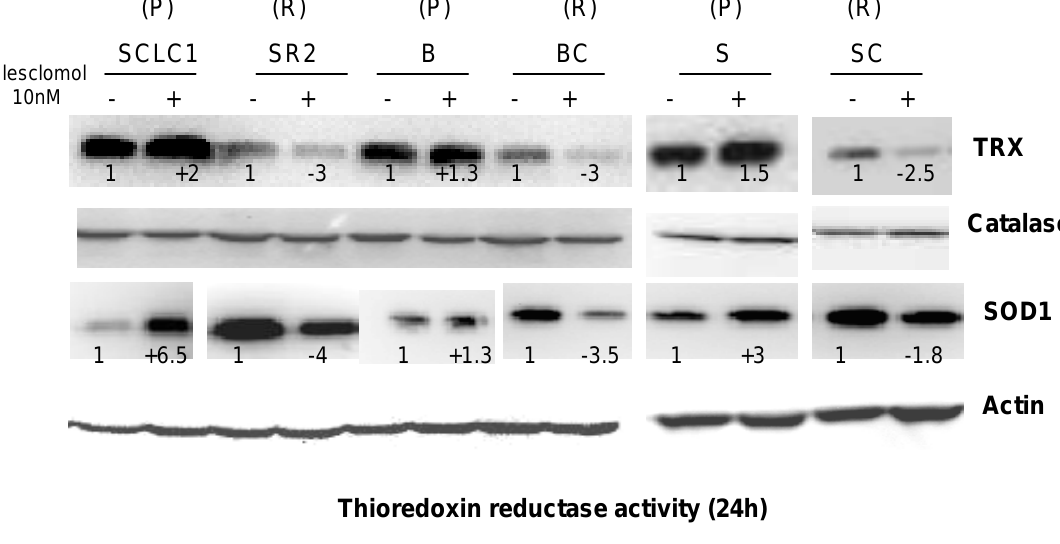
Figure 9. Immunoblot of lung cancer cell lines before and after treated with 10 nM of elesclomol for 24 h. TRX and TrxR activity are decreased in resistant lines and further decreased when treated with elesclomol. There is no significant change in catalase level. On the other hand, SOD1 levels are increased in all of the resistant cell lines (R) and is decreased upon treated with elesclomol. The number below each lane depicted the changes from its control which was arbitrarily set at 1. All the band intensity was normalized